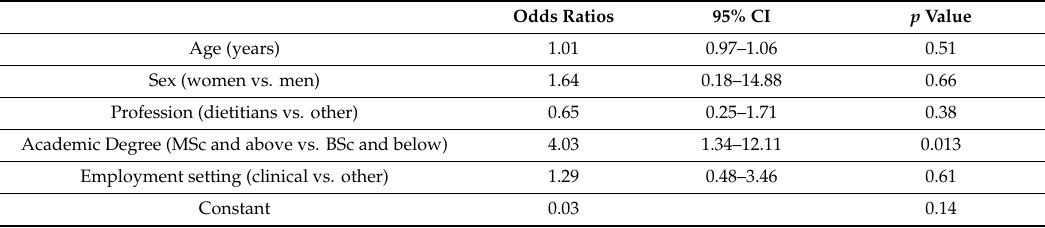
Table 3. Factors associated with total knowledge score higher than nine points in multivariable logistic regression